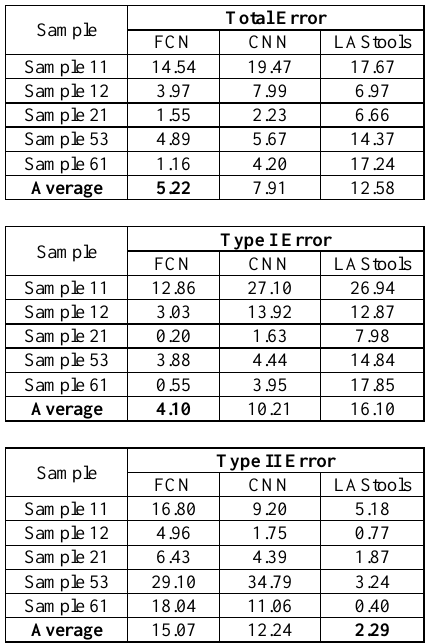
Table 5. A comparison between the accuracies obtained by the proposed method, the previous CNNs approach, and LAStools. Compared to previous deep learning algorithm using CNN proposed by Hu and Yuan (2016), FCN approach gives a lower total error.